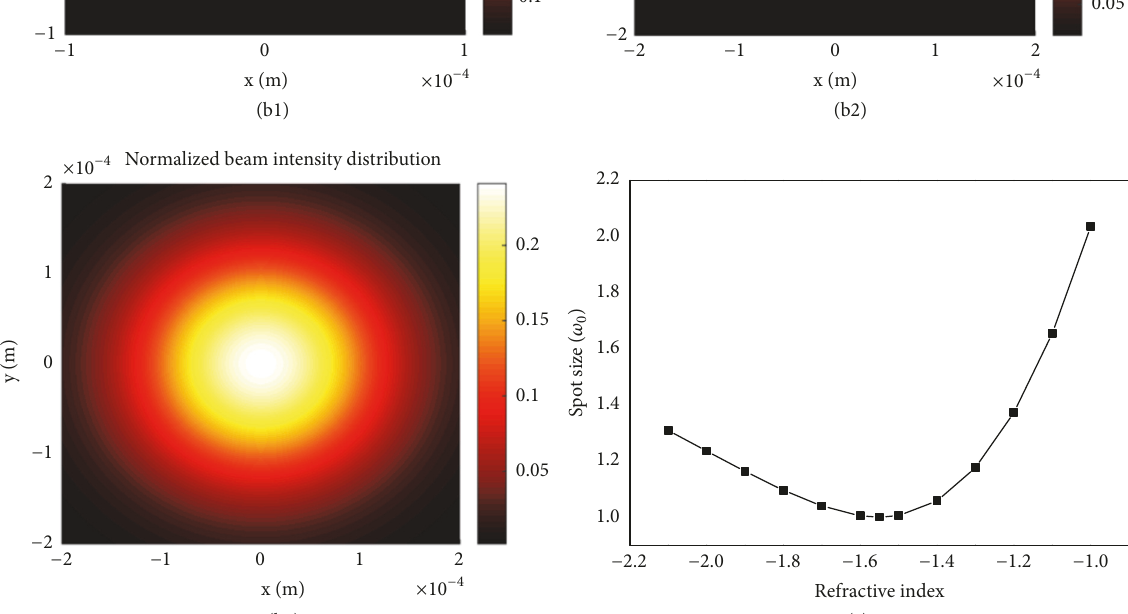
Figure 2: Optical parameters of GB versus different negative refractive indexes with 𝑚 =1, 𝜔 0 =0.1 × 10 −3 m, 𝑛 𝑟 =1.55, 𝑍 𝑅 =4.9646cm, 𝐿 =5.0 𝑍 𝑅 , 𝑅 =2.5Z 𝜆 =632.8nm fixed: (a1) incident beam distribution, 1D; (a2) incident beam distribution, 2D; (b1) emerging beam distribution, R , and DNM 𝜔 𝑝𝑒 = 𝜔 𝑝𝑚 = 2𝜋 ] × √2.55 ; (b2) emerging beam distribution, DNM 𝜔 𝑝𝑒 = 𝜔 𝑝𝑚 = 2𝜋 ] × √3.1 and (b3) emerging beam distribution, DNM 𝜔 𝜔 2𝜋 ] × √ 2 ; (c) beam spot size distribution 𝑝𝑒 = 𝑝𝑚 =